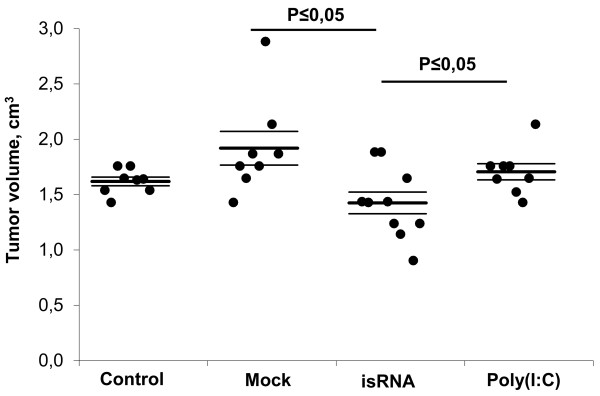
Influence of isRNA injections on HCC primary tumor growth. CBA/LacSto mice were intramuscularly injected with G-29 cells and treated with isRNA or poly(I:C) i.p. injections. The data represent means ± standard error of the mean (SEM) at day 22 (n = 8–10). P ≤ 0.05 according to Mann–Whitney test.